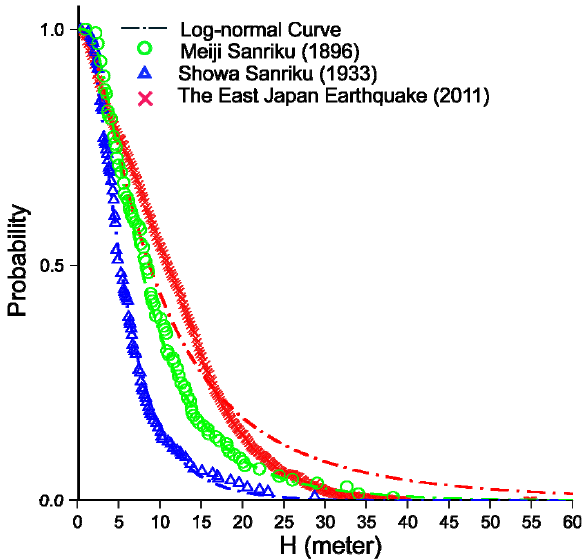
Figure 3. Cumulative distribution (probability) for tsunamis runup heights. The symbols are 5 Fig. 3. Cumulative distribution (probability) for tsunamis runup each tsunami events. The solid lines are log-normal curves. 6 heights. The symbols are each tsunami events. The solid lines are log-normal curves. The influence of the spatial correlation scale of observation data is demonstrated in Fig. 4 8 where the probability function is plotted with different scales of averaging of observed runup 9 heights. The spatial scale of 7.5 kilometres provides the best comparison of the theoretical 10 curve with observational data, and therefore this scale can determine the correlation length 11 characterizing the independence of different locations of runup measurements. 12